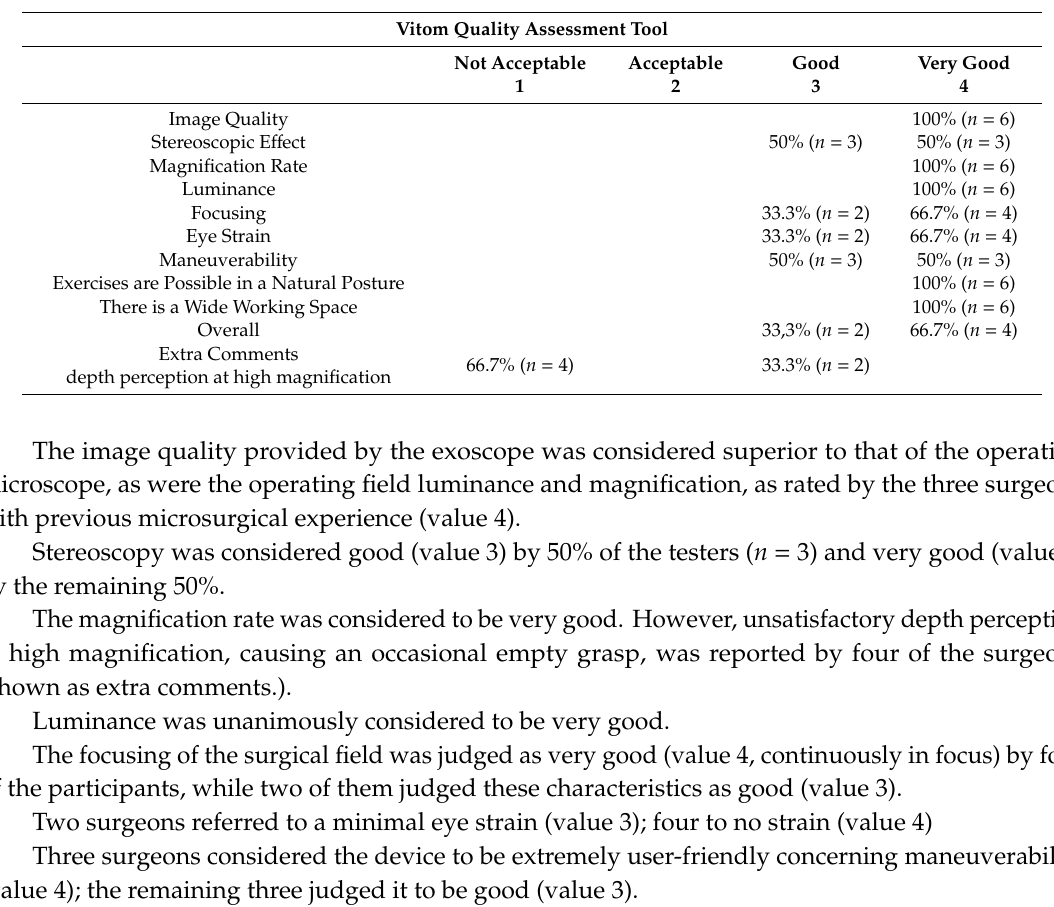
Table 2. The results of the reported evaluation of the tool’s qualities, (VITOM Quality Assessment Tool) are